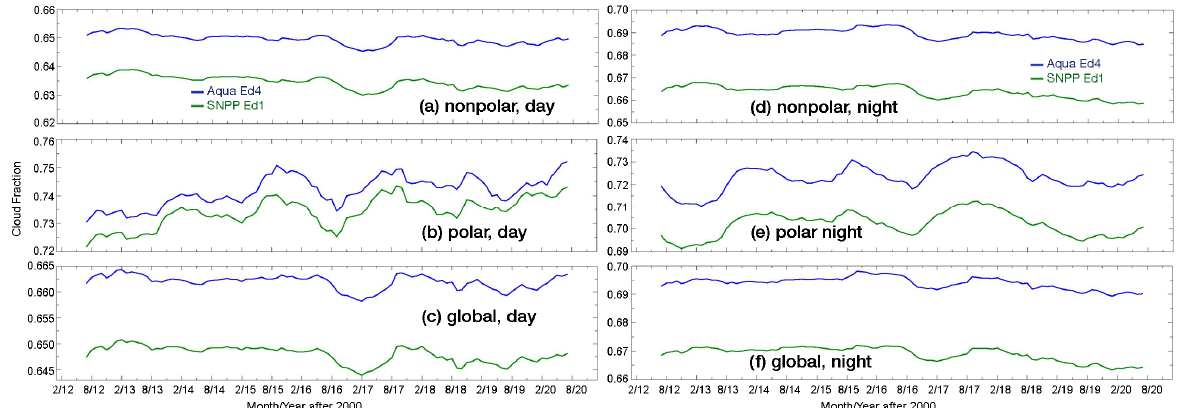
Figure 3. Time series of 12-month running mean cloud amount during daytime ( left ) and at night ( right ) over nonpolar ( top ), polar areas ( middle row), and the globe ( bottom ) for Aqua Ed4 (blue) and SNPP Ed1a (green). Note the scale differences among the plots.